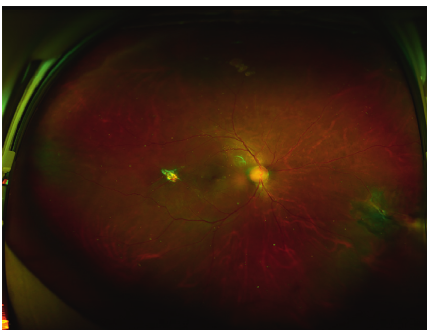
Figure 1: Postoperative wide-angle fundus photograph showing the lesion located 2.5 papillary diameters from the central